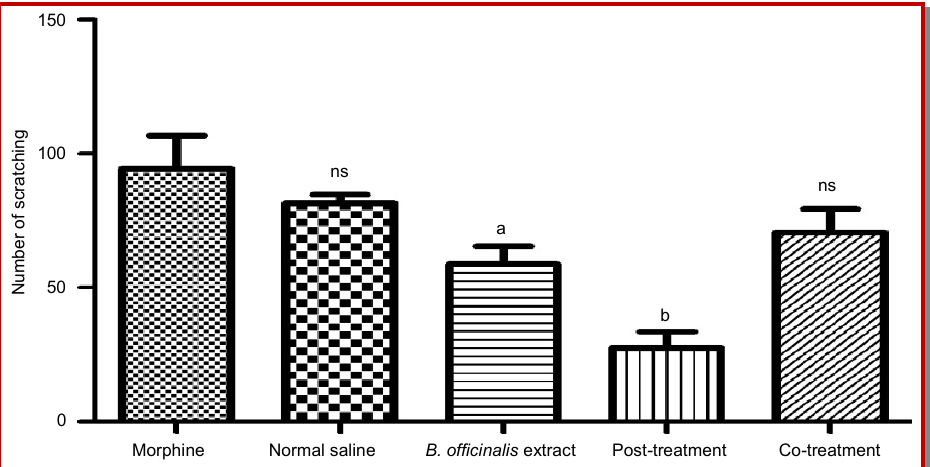
Figure 4: The effect of Borago officinalis extract, as post-treatment and co-treatment, on the frequency of scratching in the morphine- dependent mice after naloxone injection in morphine-dependent mice; a p<0.05; b p<0.01; ns: Not significant